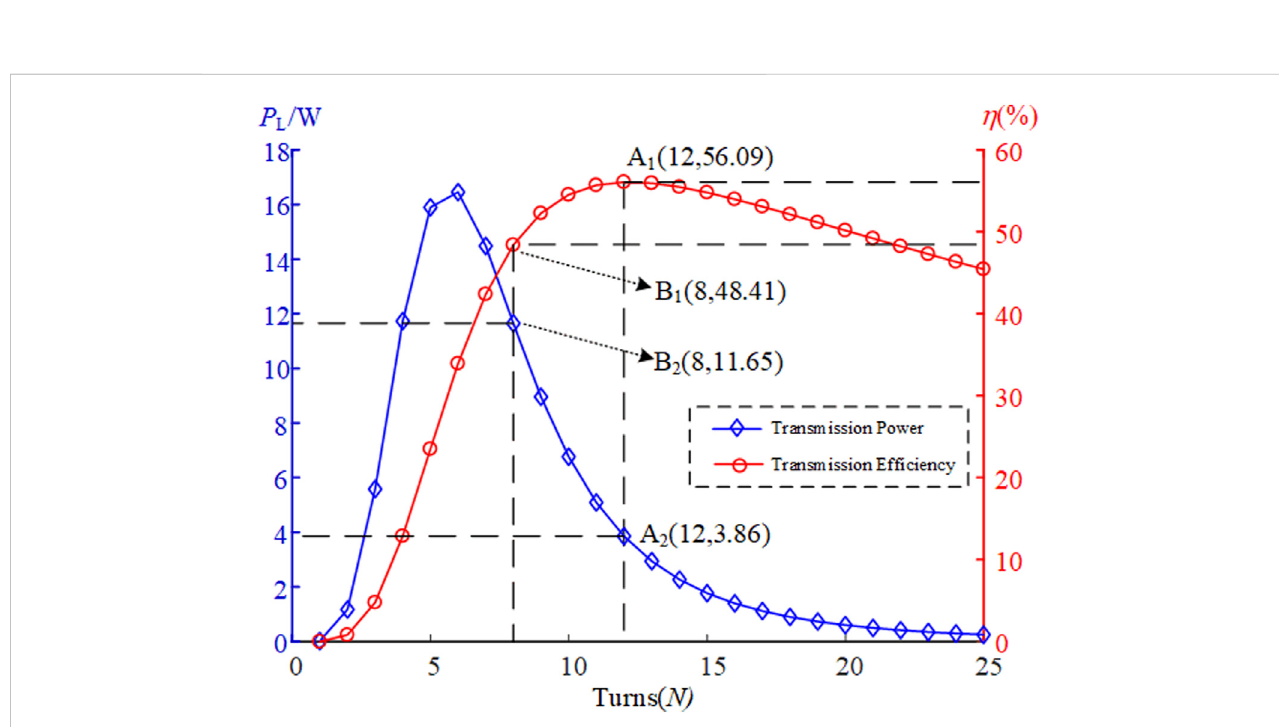
FIGURE 7 The performance of the six-relay coil WPT system varies with N or